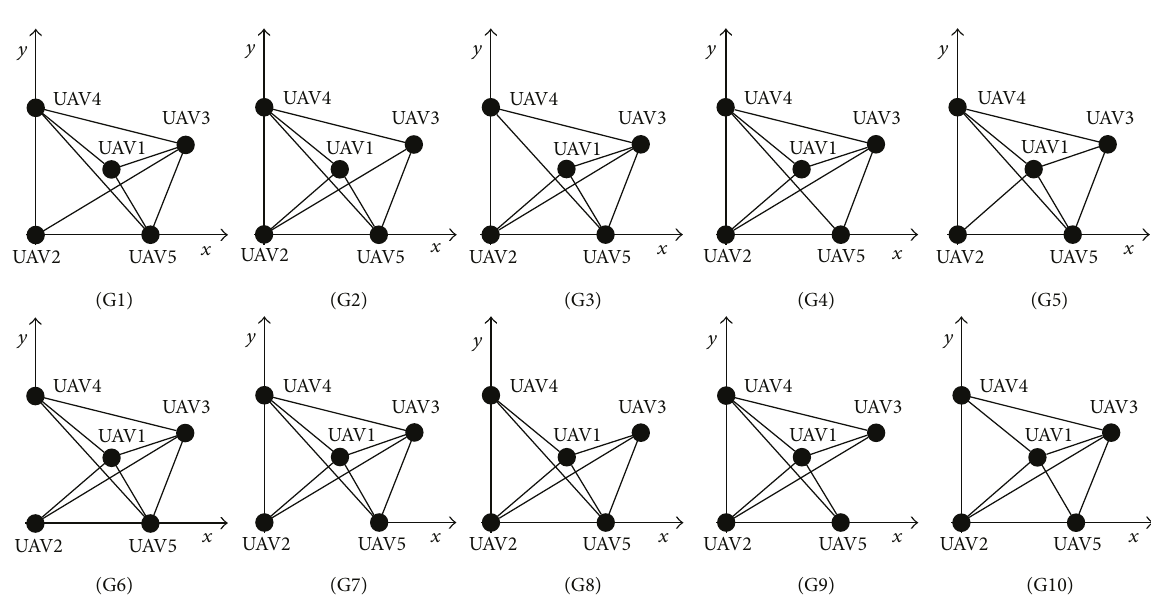
Figure 7: The candidate minimally rigid graphs for fi ve UAVs in 3D space.